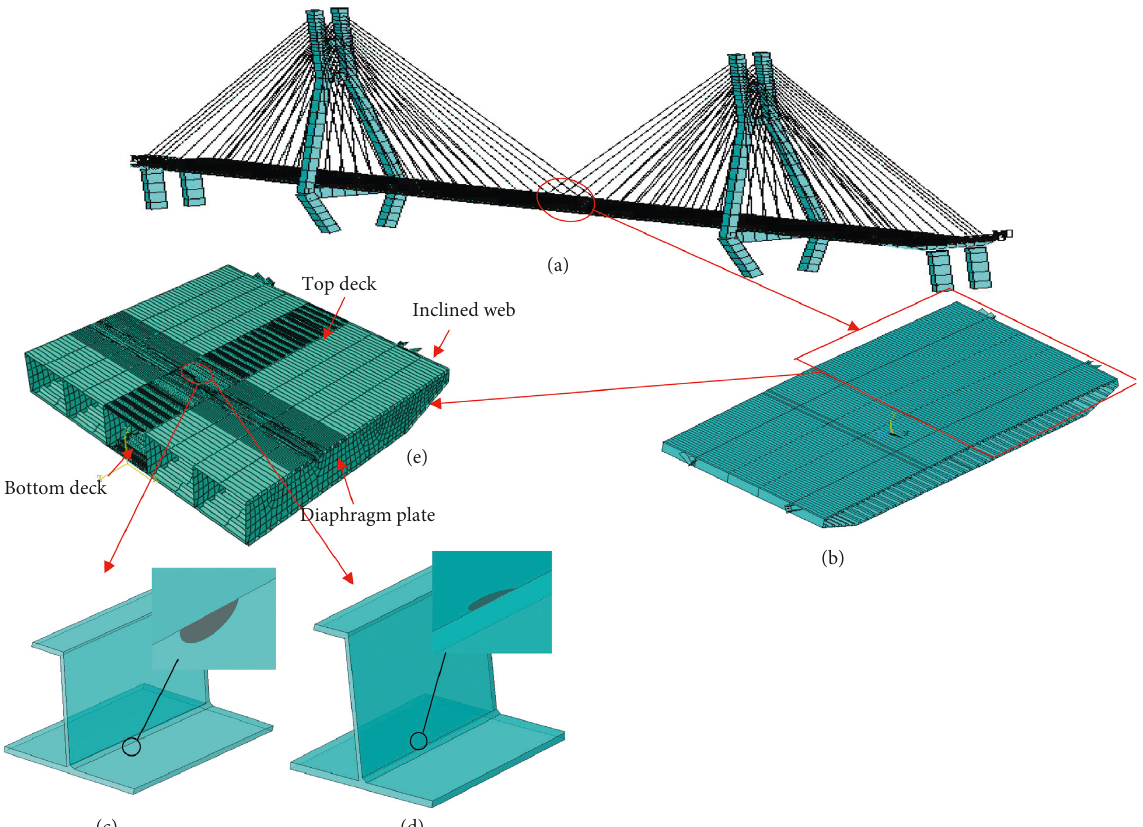
Figure 5: A multiscale finite element model of Runyang Yangtze River Highway Bridge. (a) Integral bridge model. (b) Orthotropic steel box girder including U-rib. (c) Crack at toe of top deck. (d) Crack at toe of U-rib. (e) Half of steel box girder model.